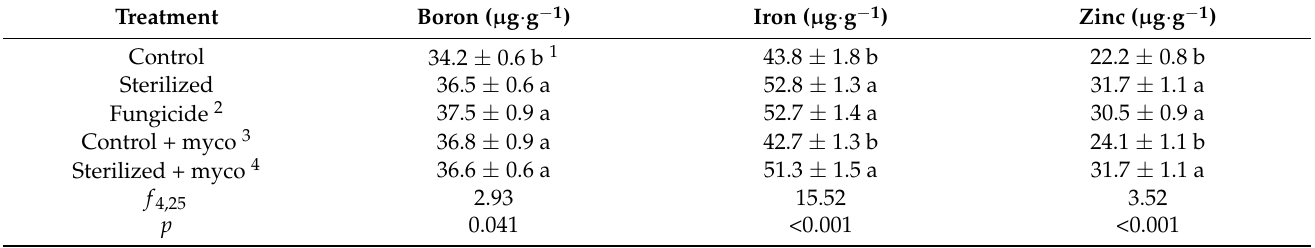
Table 11. The influence of growing Serianthes grandiflora plants in soil obtained from Serianthes grandiflora. rhizosphere on leaf micronutrient content. Mean ± SE, n =